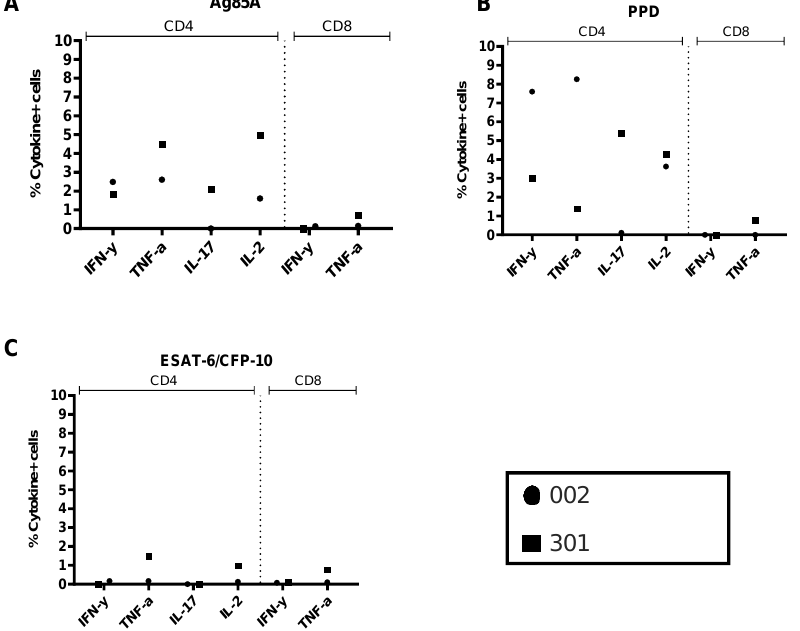
Figure 5. Bronchoalveolar lavage (BAL) intracellular cytokine staining (ICS) 7 days after